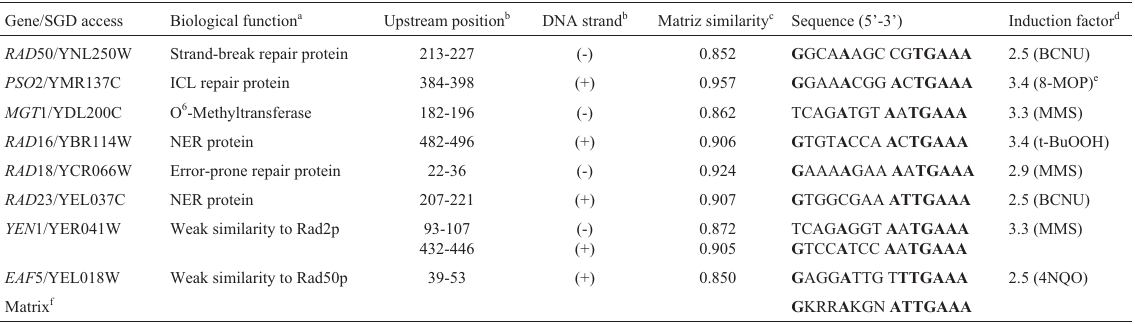
Table1 -ComputationalanalysisofDNArepairsgenesfrom S.cerevisiae identifiedbyMatInspectoralgorithmcontainingDRE-matrixelementsintheir promoters. Gene/SGD